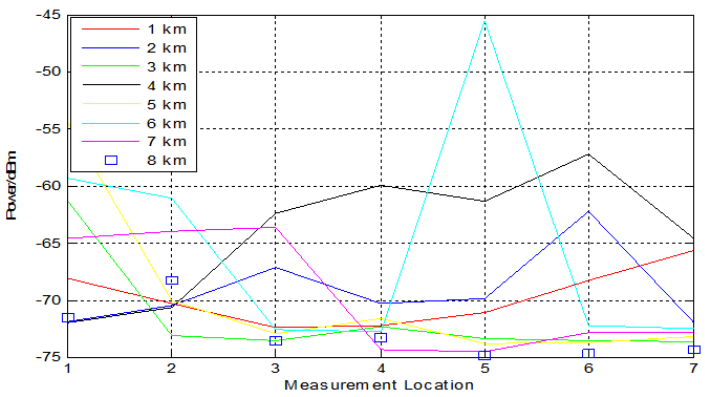
Figure 8. Radiofrequency intensities at various measurement locations of different distances from the transmitter for the 542 MHz frequency taken from the sub 700 MHz frequency band